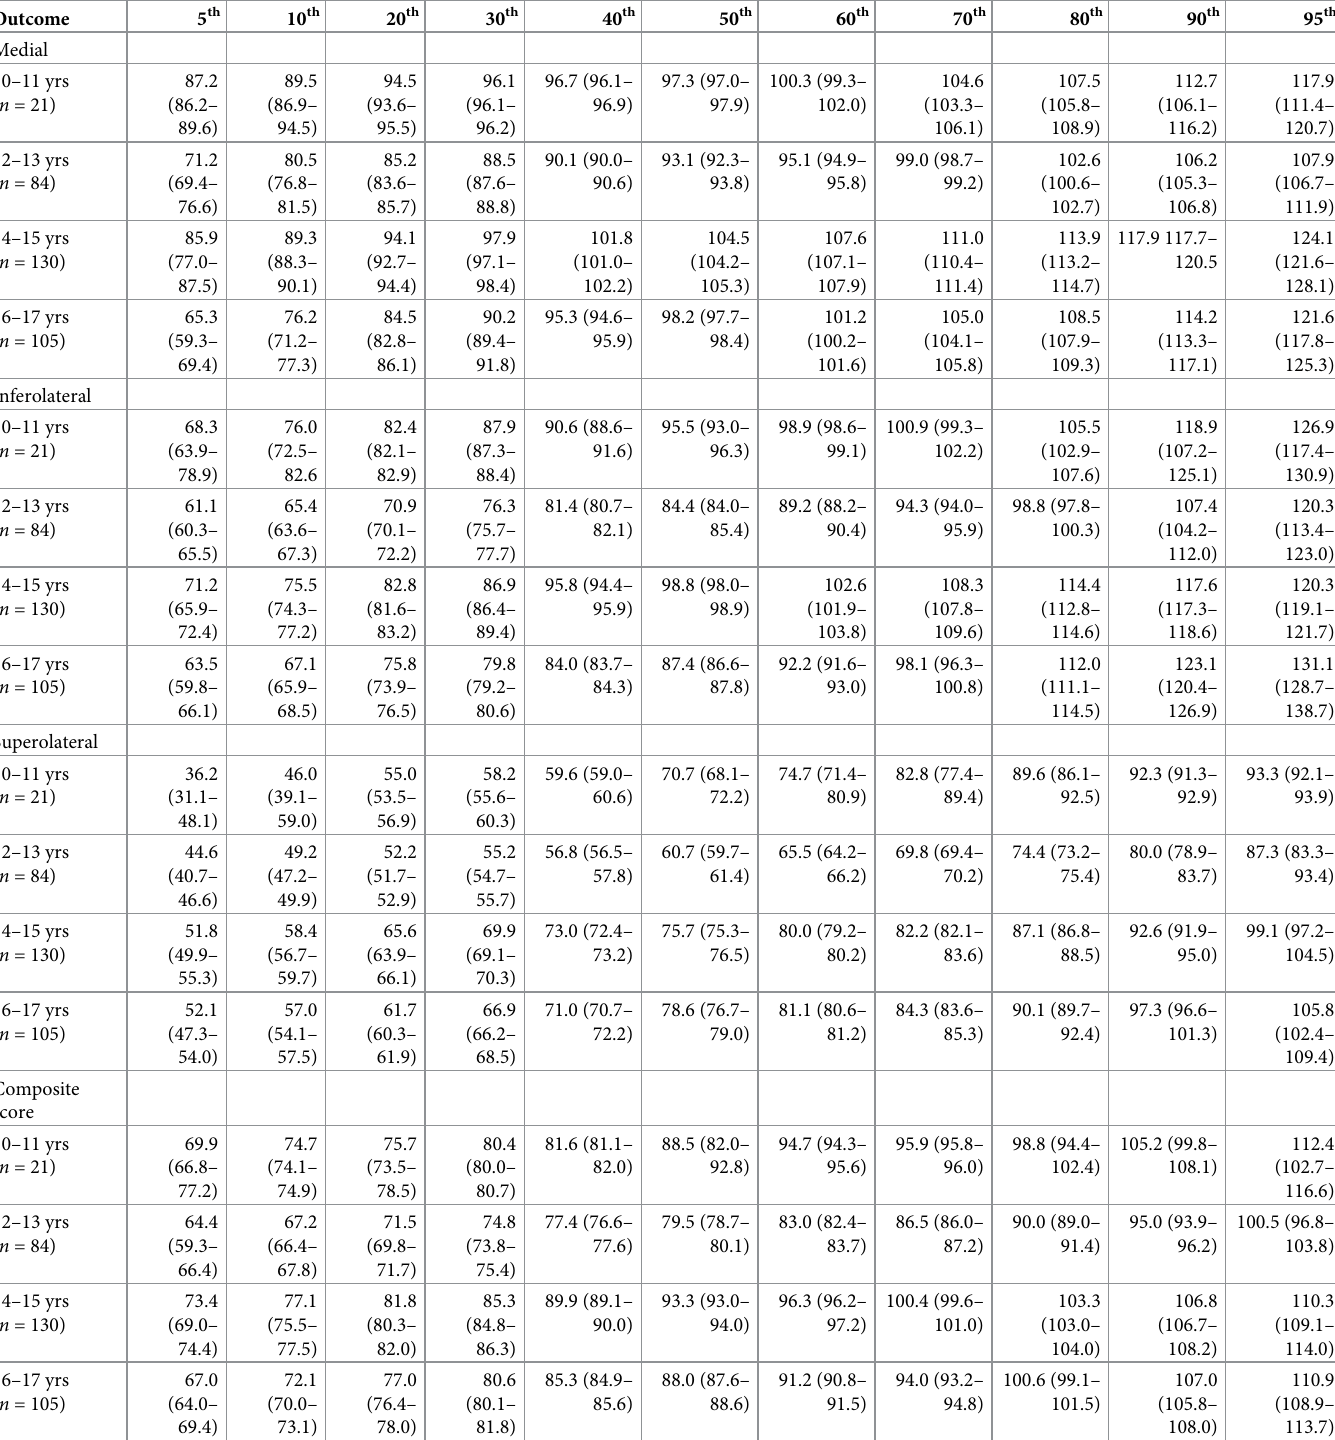
Table 3. Smoothed age-specific percentile values with 95% confidence interval for the normalized (% arm length) maximal right arm reach distances and the com- posite score in males ( n = 340) aged 10 to 17